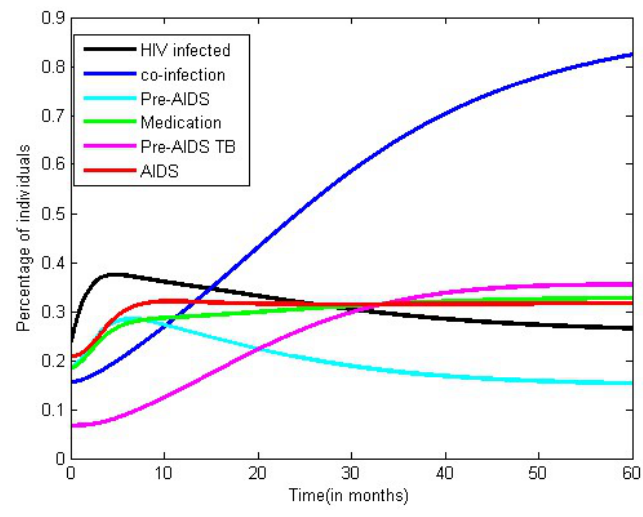
Figure 3. Transmission of HIV–TB co-infection.